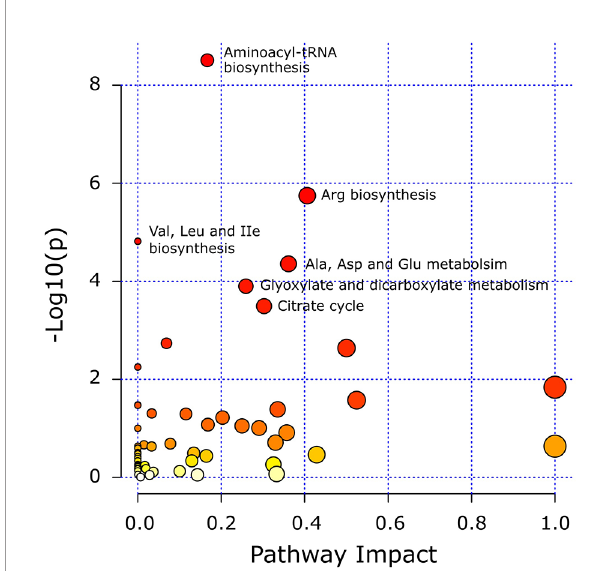
FIGURE 7 | Matched metabolic pathway plot by using identi fi ed metabolites in MMTV-PyMT mice. The x-axis marks the pathway impact. The y-axis marks the pathway enrichment. Each node represents a pathway. The nodes with larger sizes and darker colors (from yellow to red) positioning towards top right region represent higher pathway impact values and higher pathway enrichment. Pathways that are signi fi cantly altered are presented with their names next to their nodes and are in Table 5 . All detected metabolic pathways are presented in Supplementary Table 2 .